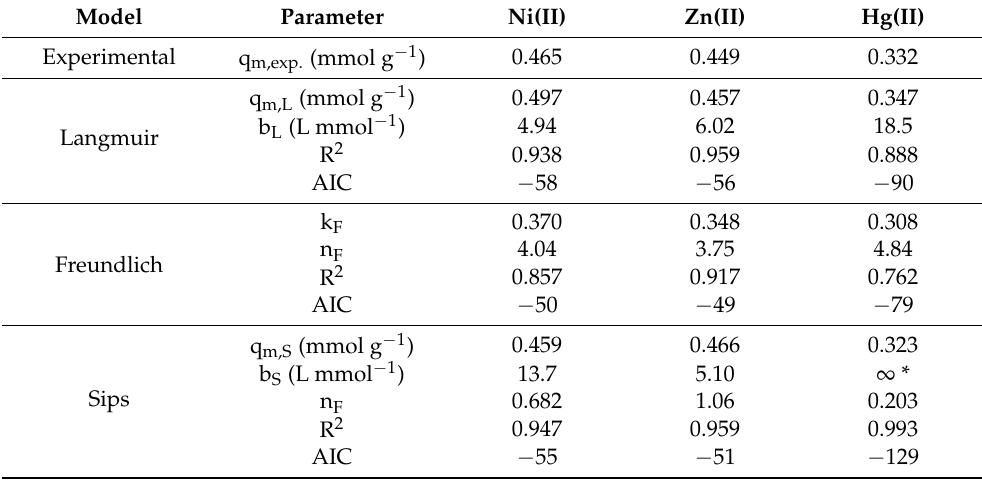
Table 3. Ni(II), Zn(II) and Hg(II) sorption isotherms using G@MChs—parameters of the models.